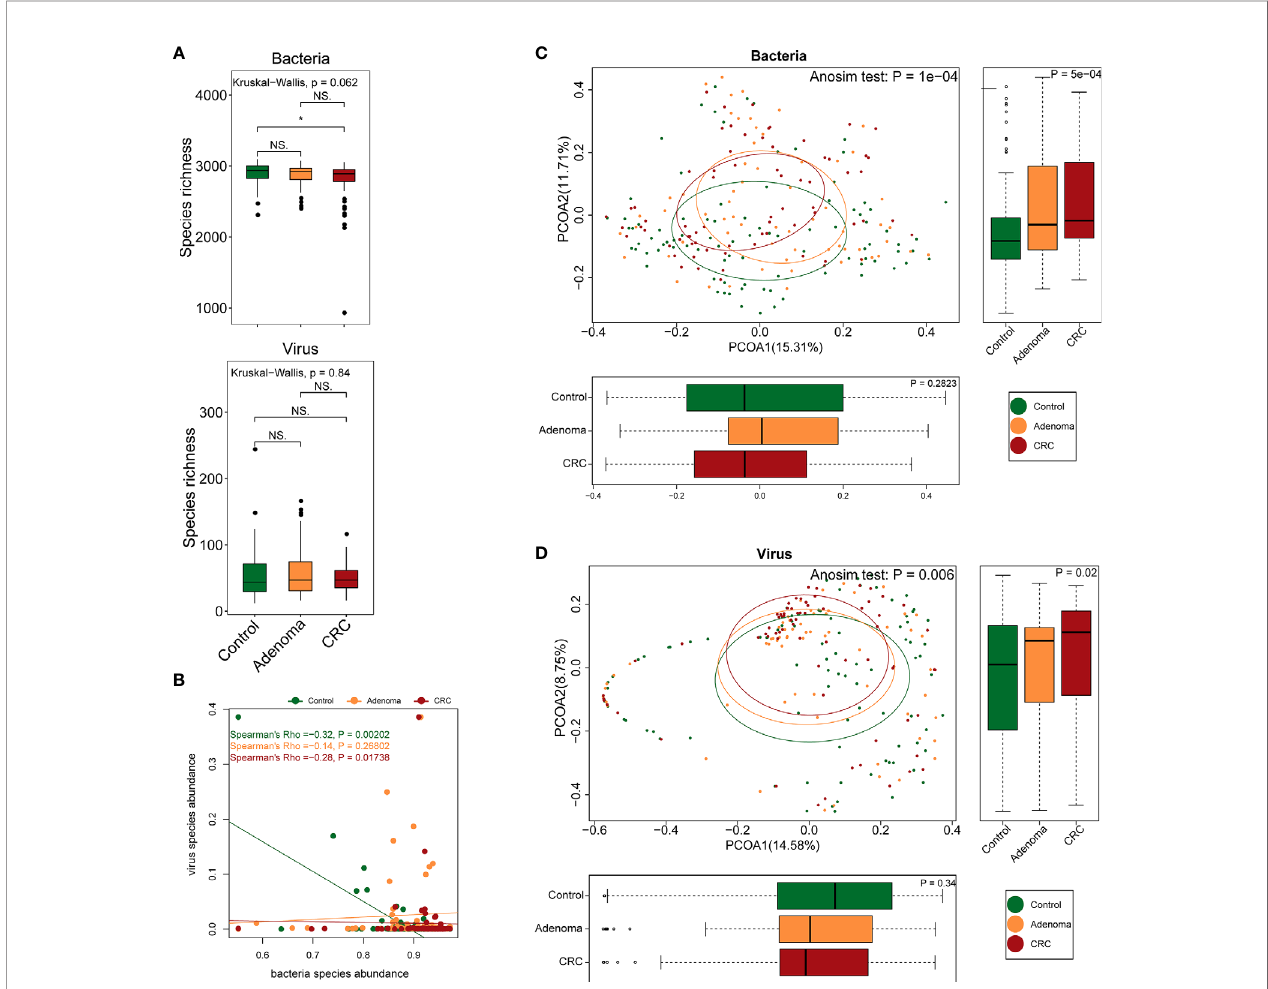
FIGURE 1 | Differences in gut microbiome structure among the control (colored in green), adenoma (colored in amber), and CRC (colored in dubonnet) groups. (A) Comparison of bacterial or viral richness (*P < 0.05). (B) Association of bacteria and viruses. (C) Principal coordinate analysis of the bacteria. (D) Principal coordinate analysis of the viruses. NS, Not signi fi